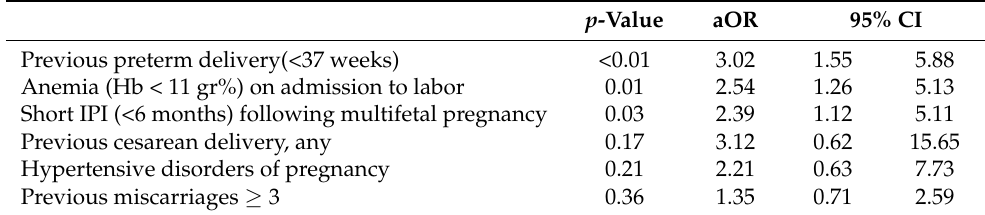
Table 4. Multivariate logistic regression analysis for the association between baseline characteristics and preterm delivery < 37 weeks (Adjusted Odds Ratio).